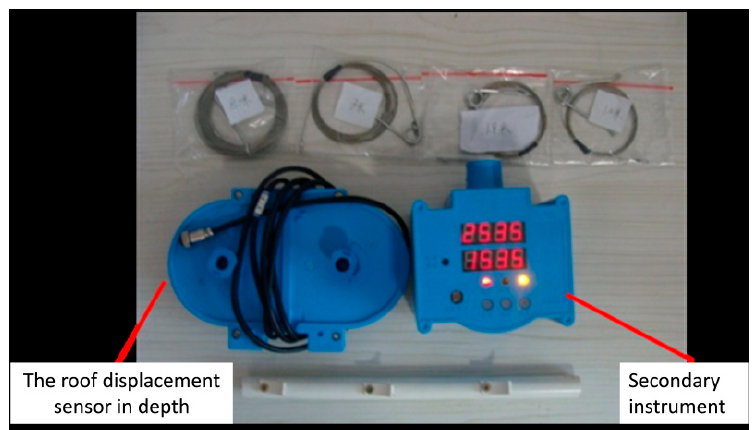
Figure 8. Separate multiple basic points deep displacement monitor.